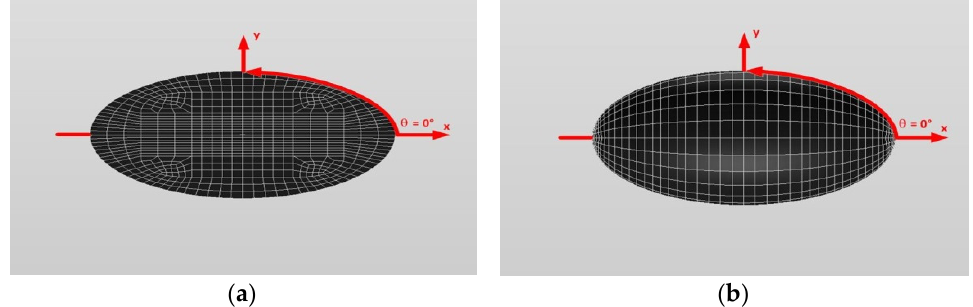
Figure 16. A typical discretized oblate spheroidal model (b/a = c/a = 0.5) in the volume integral equation method (VIEM). ( a ) An inside view of an oblate spheroidal model. ( b ) An oblate spheroidal model.